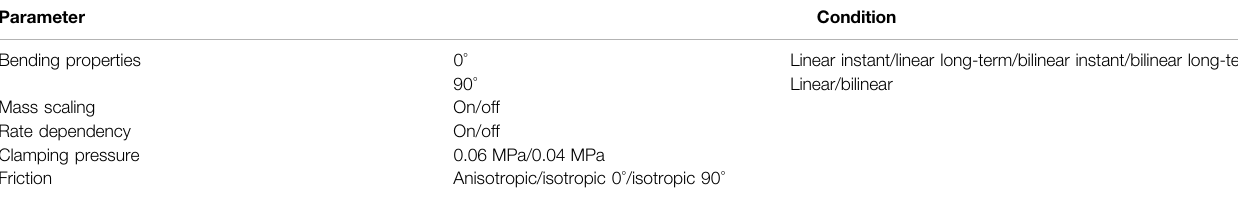
TABLE 2 | Investigated modeling approaches. Benchmark setting is